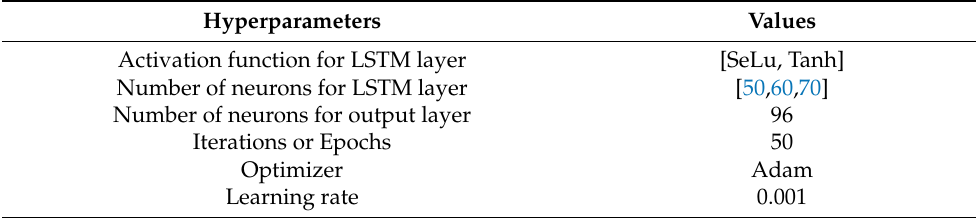
Table 3. Hyperparameters were evaluated and used to train the